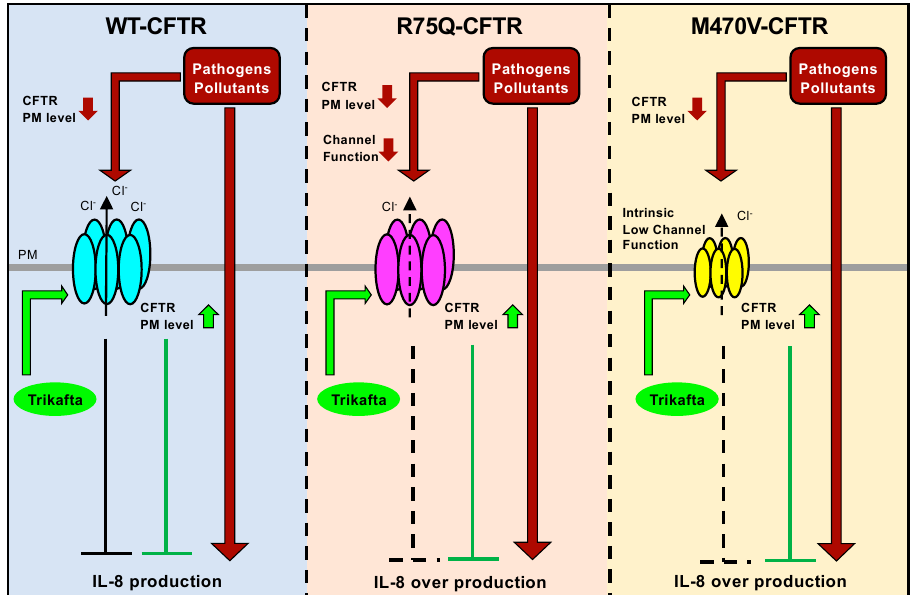
Figure 9. Putative mechanisms of the dysfunction of CFTR variants on the COPD-associated proinflammatory response. In normal airway epithelial cells expressing WT-CFTR, the production of proinflammatory cytokines, such as IL-8 and IL-6, is properly regulated because WT-CFTR suppresses excess cytokine production. Environmental pathogens and/or pollutants reduce the CFTR PM expression, leading to augmenting IL-8 production as a proinflammatory response. In the airway epithelial cells expressing R75Q-CFTR or M470V-CFTR, exposure to environmental pathogens and/or pollutants induces IL-8 overproduction because these CFTR variants fail to suppress cytokine production. Environmental pathogens and/or pollutants reduce the PM level and function of CFTR variants, which may further augment the dysfunction of CFTR variants frequently observed in COPD patients. CFTR modulator Trikafta can suppress the overproduction of proinflammatory cytokines in airway epithelial cells by increasing the PM expression of WT-CFTR and CFTR